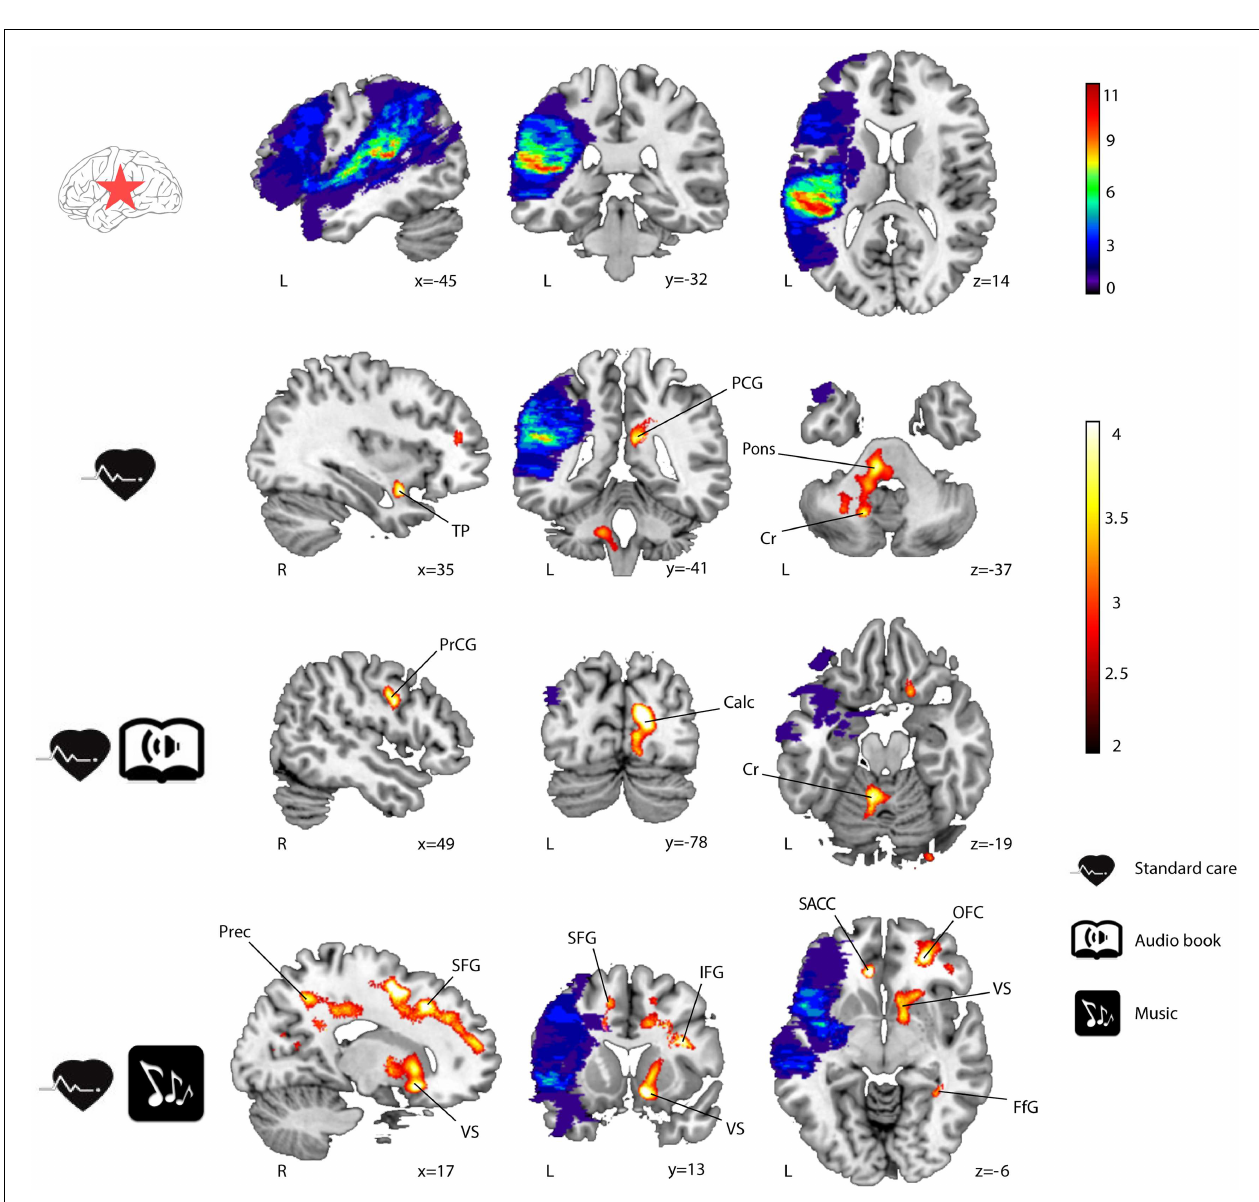
right of each slice. Only clusters surviving a p < 0.001 threshold are labeled (see also Table 3 ).TP, temporal pole; PCG, posterior cingulate gyrus; Cr, cerebellum; PrCG, precentral gyrus; Calc, calcarine; Prec, precuneus; SFG, superior frontal gyrus;VS, ventral striatum; IFG, inferior frontal gyrus; SACC, ventral/subgenual anterior cingulate cortex; OFC, orbitofrontal cortex; FfG, fusiform gyrus; L, left hemisphere; R, right